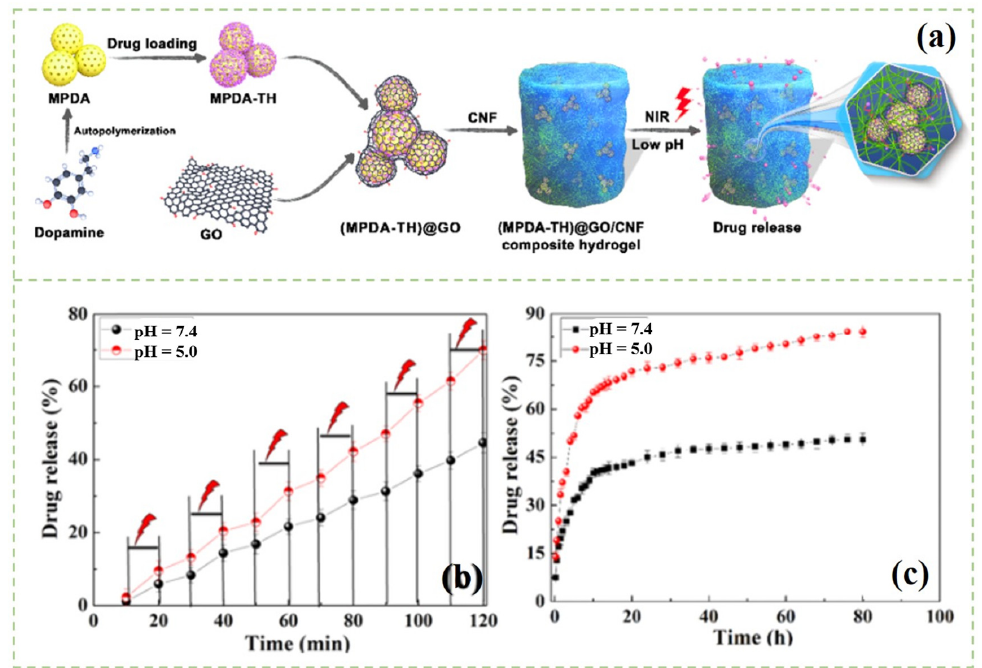
Figure 4. ( a ) Schematic illustration of the fabrication of the MPDA@GO/CNFs composite hydrogel; ( b ) NIR-light-triggered drug release behavior from MPDA@GO/CNFs composite hydrogel in different PBS solution at 37°C; ( c ) In vitro drug release profiles of the MPDA@GO/CNFs composite hydrogel [106].